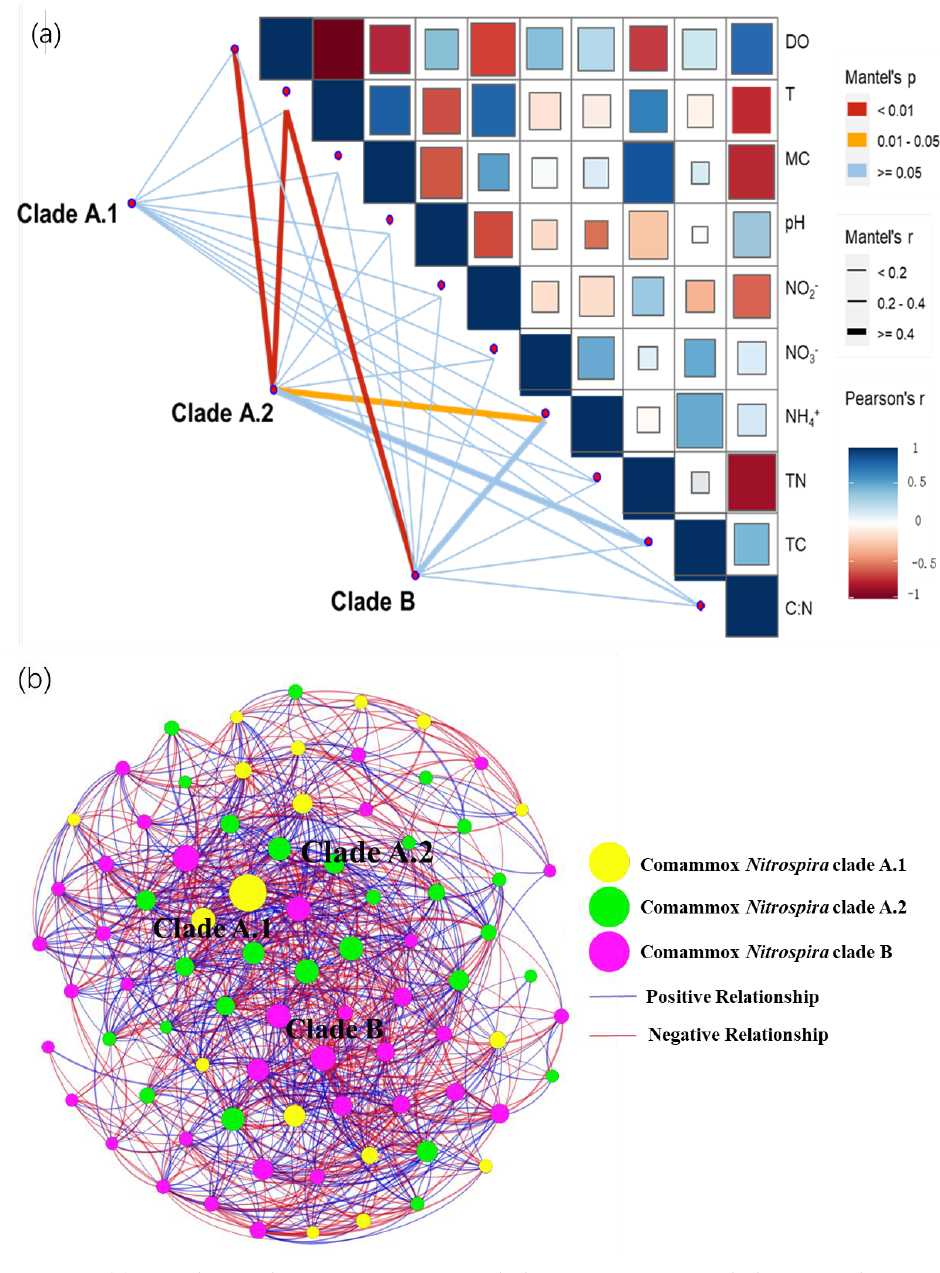
Figure 5. ( a ) Correlations between comammox clade A.1, comammox clade A.2, and comammox clade B abundances and environmental physicochemical indicators. ( b ) Contribution analysis of each clade network of comammox clades A.1, A.2, and B. Each node in the network represents a microbial population. The size of the nodes indicates the degree of connection, and the color of the nodes indicates the different main species. Blue lines represent a positive correlation, whereas red lines represent a negative correlation ( p < 0.05). The size of the circle represents the specific gravity of the OTU. The numbers below the OTU color bar represent the number of OTUs. The two axes of the RDA jointly explain 99.60% of the species information change and the species – environment relationship (Supplementary Figure S3). The abundances of amoA genes in the two clades of comammox Nitrospira showed a significant positive cor- relation (r = 0.26, p < 0.05, n = 9). The abundance of comammox Nitrospira clade A amoA genes was positively correlated with NO 3 − (r = 0.23, p < 0.05, n = 9) and DO (r = 0.17, p < 0.05, n = 9). The abundances of comammox Nitrospira clade B amoA and AOB amoA genes were significantly positively correlated with TN (r = 0.01, p < 0.05, n = 9), TC (r = 0.15, p < 0.05, n = 9), and pH (r = 0.15, p < 0.05, n = 9). AOA amoA was positively correlated with NH 4+ (r = 0.14, p < 0.05, n = 9). As shown in the network plot, there are more connecting lines of positive correlations than negative correlations in the network (Figure 5b) between the OTUs, which indicates that these OTUs may have stronger cooperative mechanisms and weaker competitive mechanisms. The number of OTUs in comammox clades A.1, A.2, and B accounted for 21.78%, 19.80%, and 58.42% of the total OTUs, respectively. In the environment, comam- mox clade B displayed the highest abundance, whereas comammox clade A.1 exhibited the lowest abundance. 4. Discussion 4.1. Comammox Nitrospira Clade Differentiation In different environments, the proportion of each branch of comammox Nitrospira differs [7]. In this study, our phylogenetic tree showed that the comammox bacteria in the sample fell into three branches, namely, comammox clade A.1, comammox clade A.2, and comammox clade B. Comammox clade A was more widely distributed than comammox clade B, but the distribution difference was not significant, which might be due to the